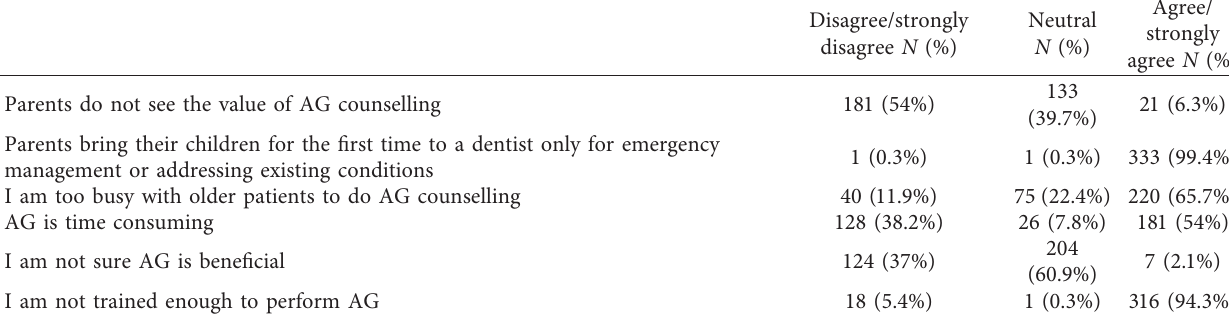
Table 2: Distribution of barriers interfering with practices of AG ( N �